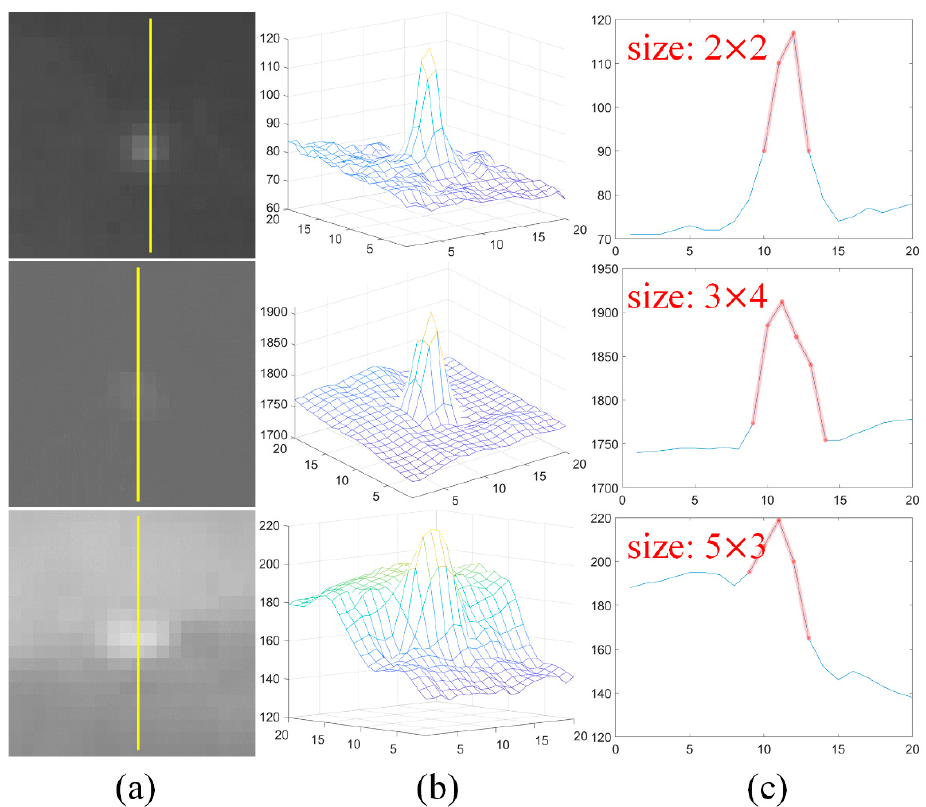
Figure 2. Demonstration of the 3-D and 1-D analysis for small IR targets with different sizes: ( a ) local patches contain targets; ( b ) 3-D mesh; ( c ) 1-D cross-section profile analysis.